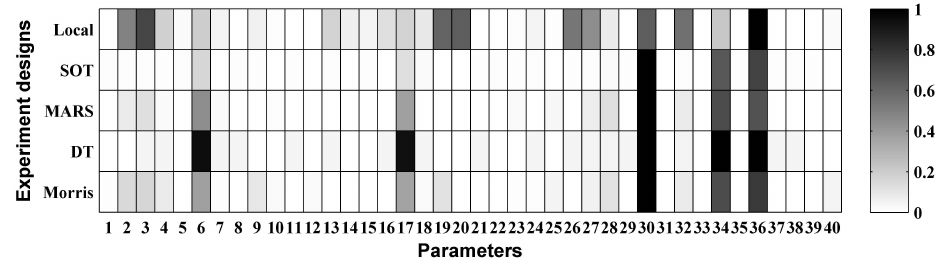
Fig. 9. The qualitative sensitivity analysis results of different methods for net radiation. The sensitivity scores are normalized to [0, 1]; 1 means most sensitive and 0 means least